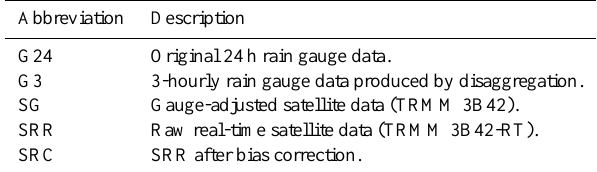
Table 2. Short identifiers for the different precipitation estimates.